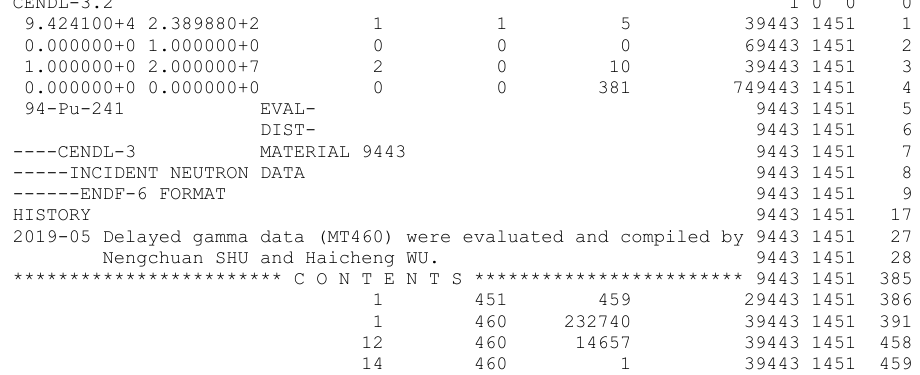
Table 2. Beta-delayed fission gamma spectrum of n+ 241 Pu fission in ENDF-6 format (MF=1, MT=451, general information) CENDL-3.2